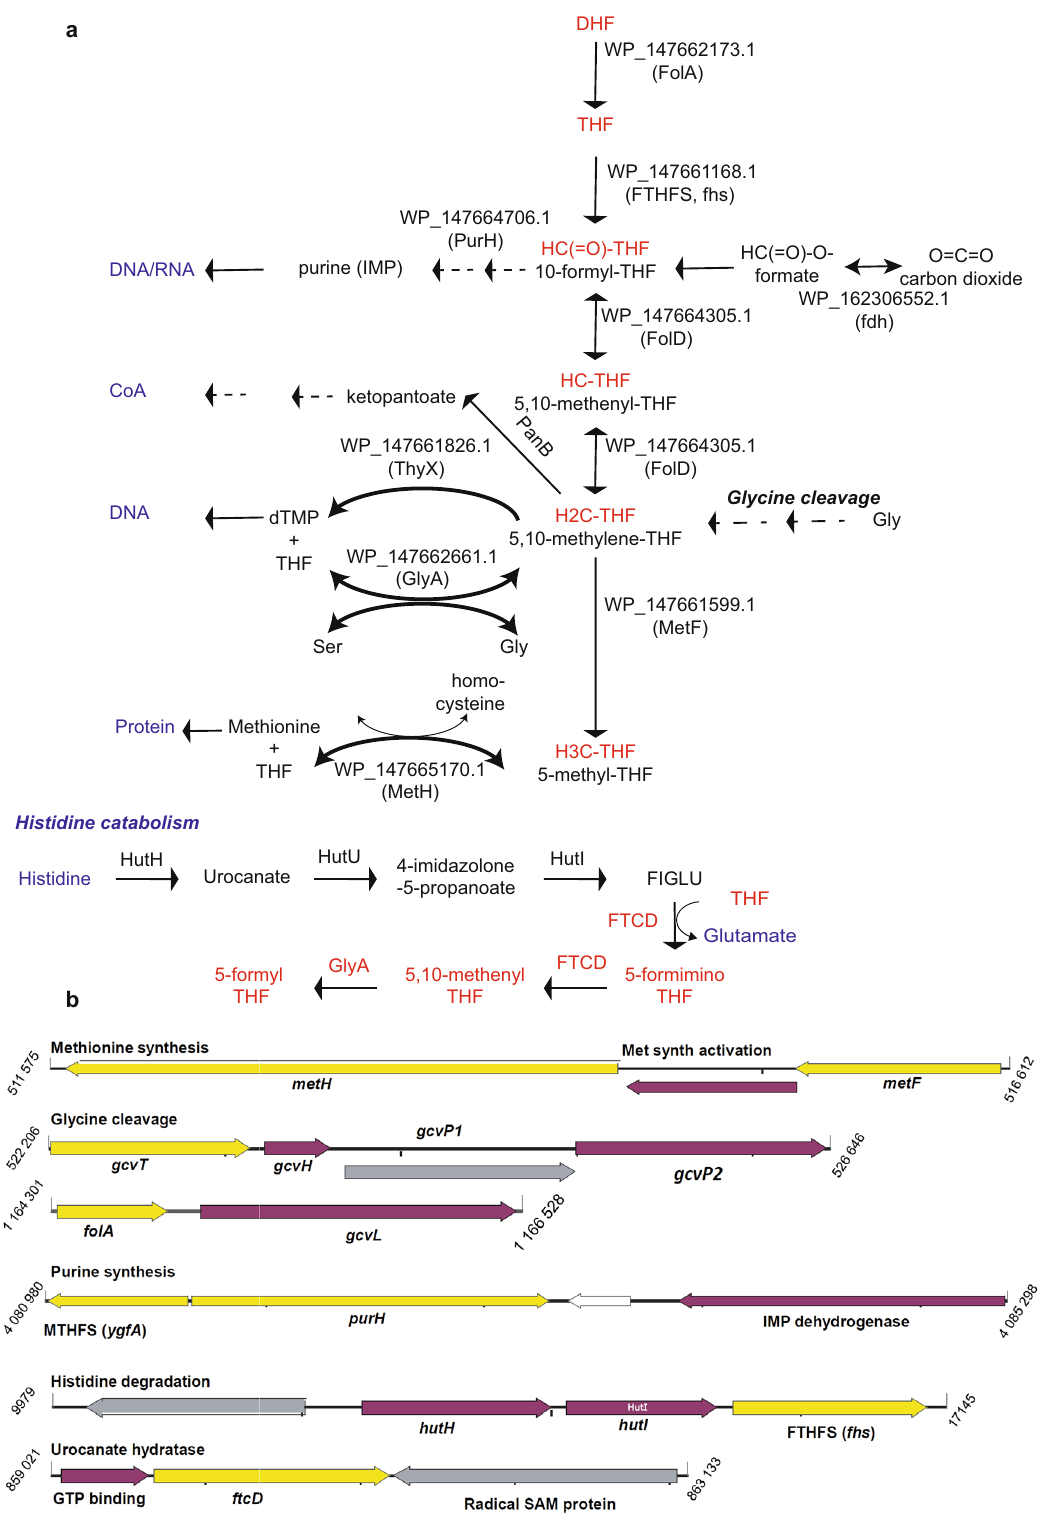
Fig. 9 | Identi fi cation and genetic connections of folate-dependent enzymes in Psyn . a Metabolic reconstruction of the complete Psyn folate-dependent metabo- lism. Abbreviations not explained in the fi gure are DHF dihydrofolate, THF tetra- hydrofolate, IMP inosine monophosphate. The previously suggested pathways identi fi ed earlier (ref. 23 ) are indicated in italics. b Functional connections between